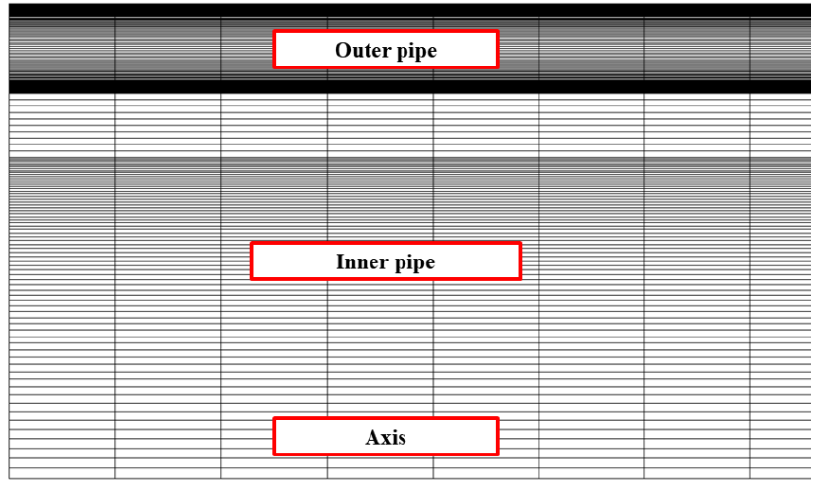
Figure 2. Mesh description.